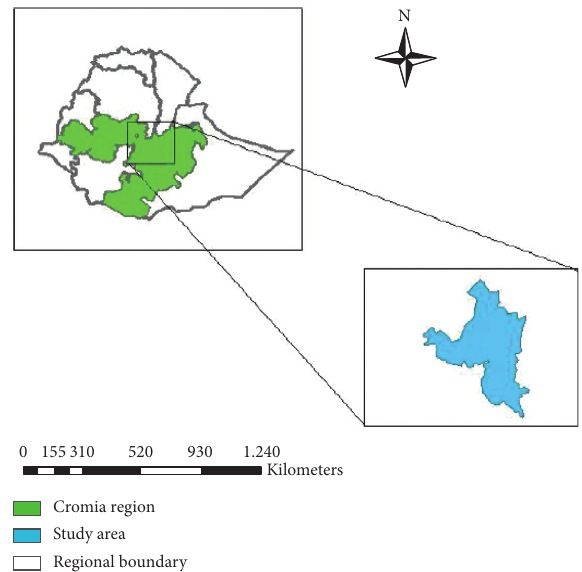
Figure 1: Map of Bishoftu town, East Shewa zone, Ethiopia. Source: Abunna et al.